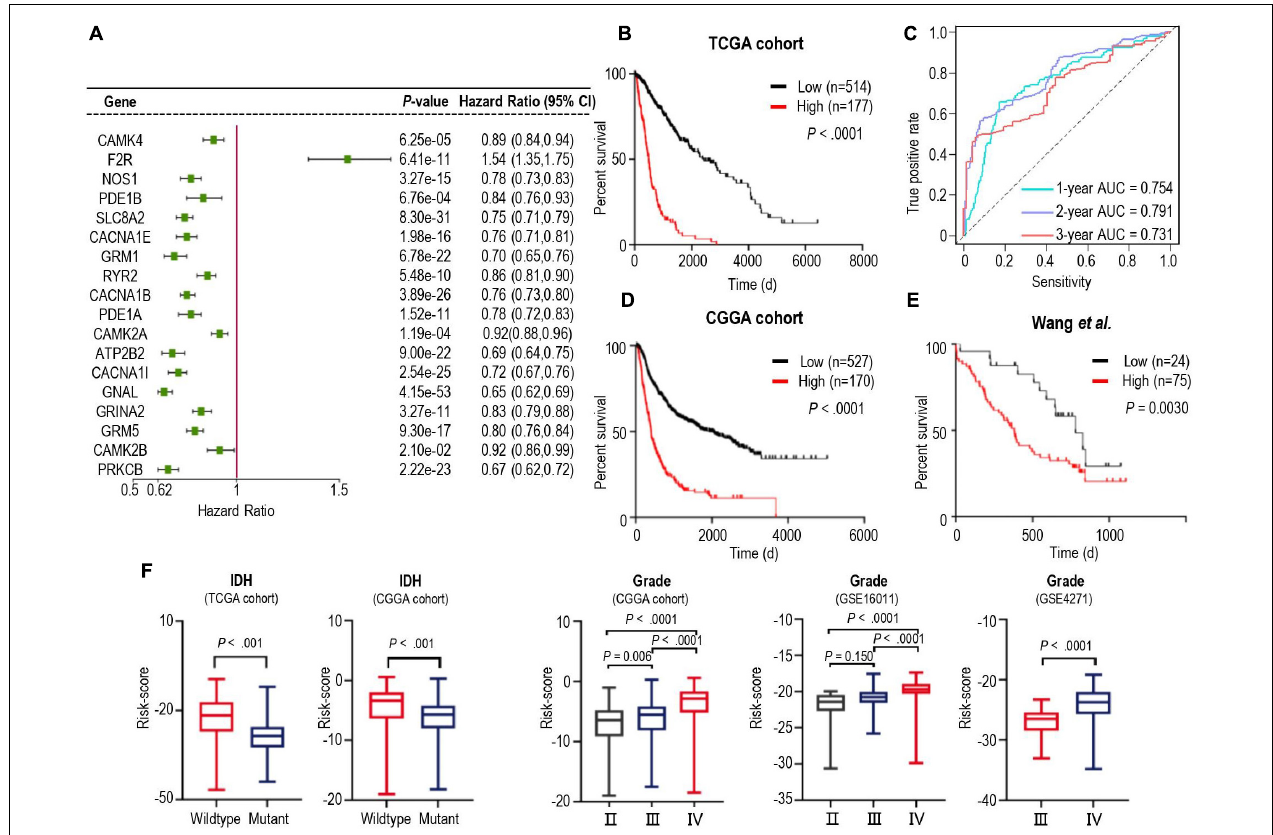
FIGURE 2 | Identification of a prognostic signature by Cox proportional model in TCGA cohort and the landscape of clinical and molecular features is associated with calcium pathway-related risk-score. (A) Univariate Cox regression analysis showed 18 iDEGs that were significantly associated with overall survival in the TCGA dataset. (B) Kaplan-Meier survival curves based on the risk score in the TCGA cohort. Survival curves were compared using the log-rank Mantel-Cox test. (C) 1-, 2- and 3-years overall survival ROC curves in TCGA cohort demonstrated the relatively satisfactory predictive performance. (D,E) Survival analysis of the signature in the CGGA cohort (D) and dataset from Wang et al. (2021) (E) . (F) Distribution of the risk score in stratified patients from 5 different cohorts by IDH Mutation (TCGA and CGGA) and the stage of glioma (CGGA, GSE16011, and